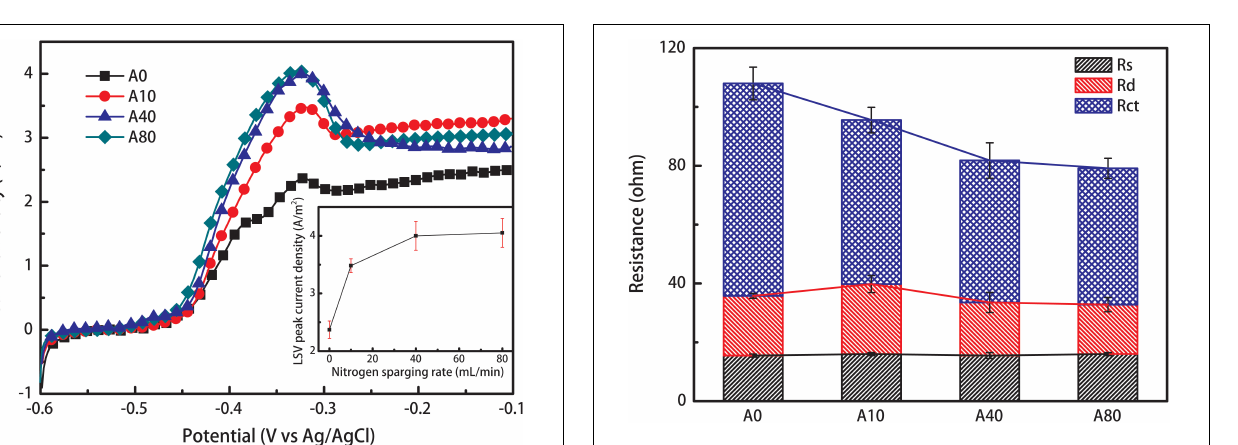
FIGURE 2 | Linear sweep voltammetry (LSV) curves of the anodes enriched with different nitrogen sparging rates. The LSV tests was performed without nitrogen sparging, indicating that shear stress affected the anode biofilm structure and therefore influenced the anode performance. The inset shows the relationship between the nitrogen sparging rate and LSV peak current density.